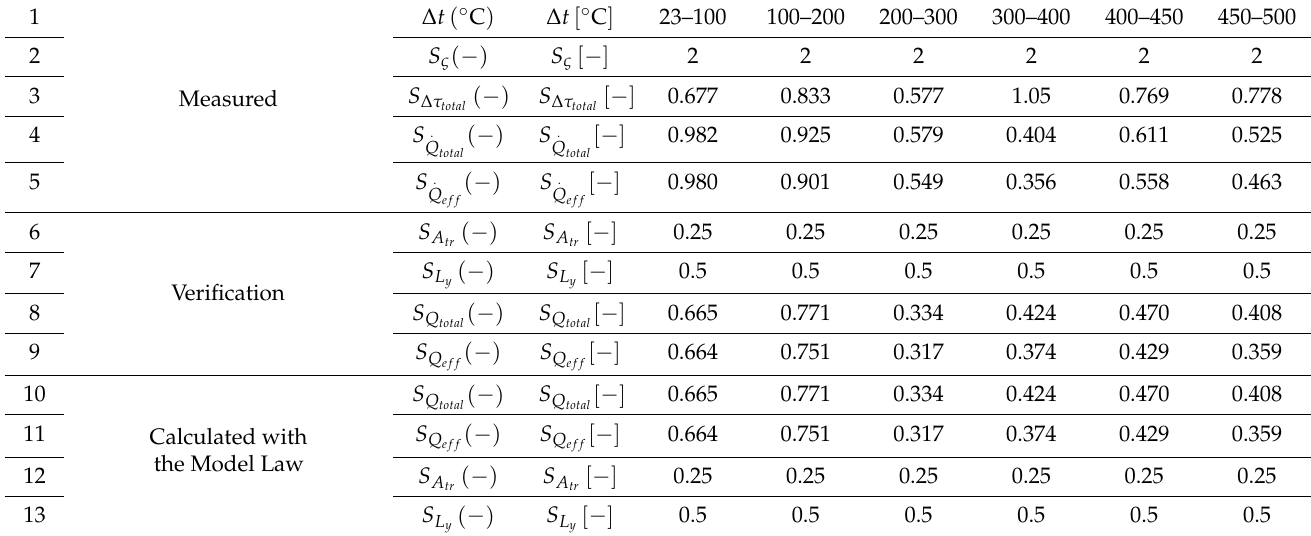
Table 7. The 1:2/1:1 unpainted model/prototype; measured values.